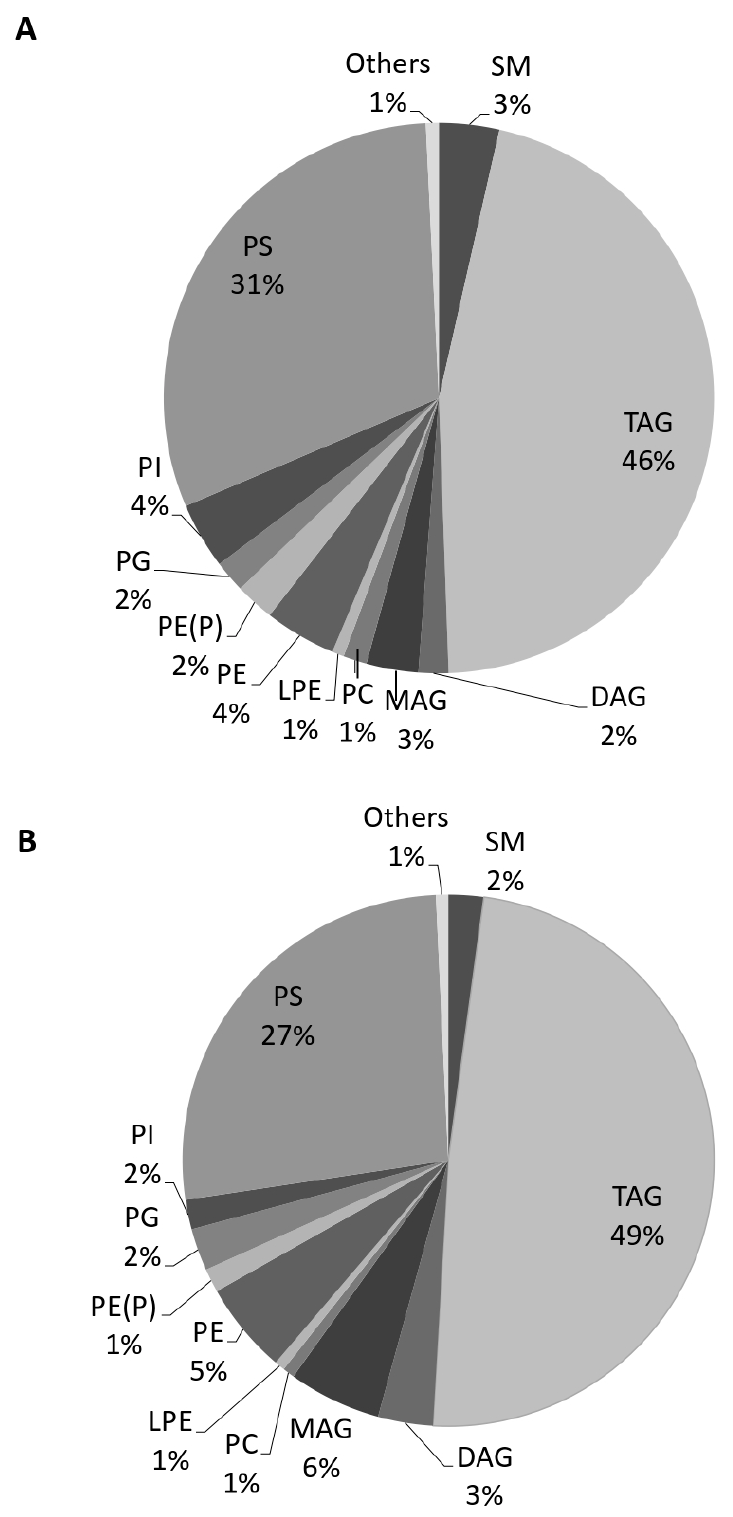
Figure 3. Exosomal lipid composition with or without Tempol treatment. Lipids were extracted from urinary EVs and quantified using targeted mass spectrometry. The total concentration of the identified lipids was calculated, and the proportion of each lipid class was presented for the samples before ( A ) and after Tempol infusion ( B ).